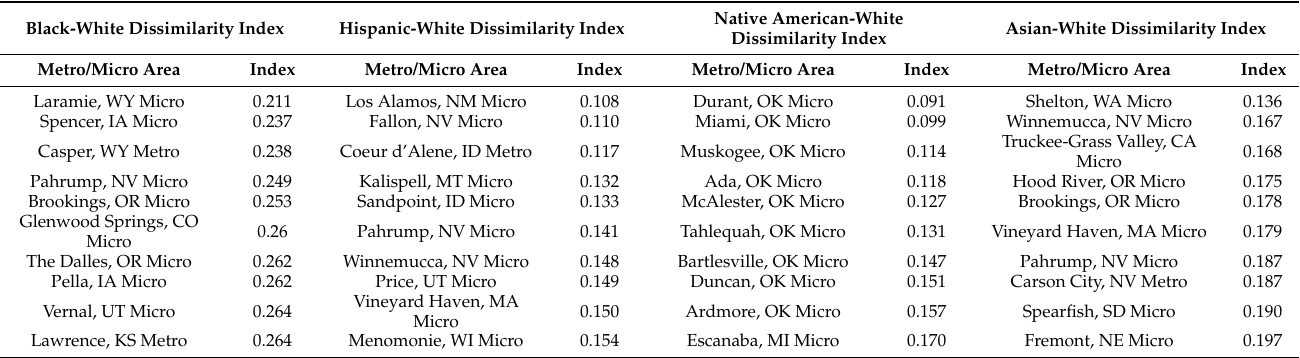
Table 6. Ten Lowest Metro/Micro Areas for Black-White, Hispanic-White, Native American-White, and Asian-White Dissimilarity Indices, 2020.